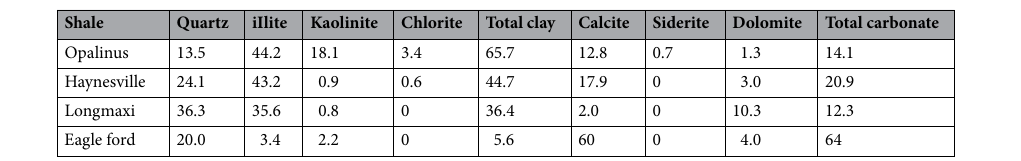
Table 2. Mineralogical composition of four shales (Vol.%) 53,54